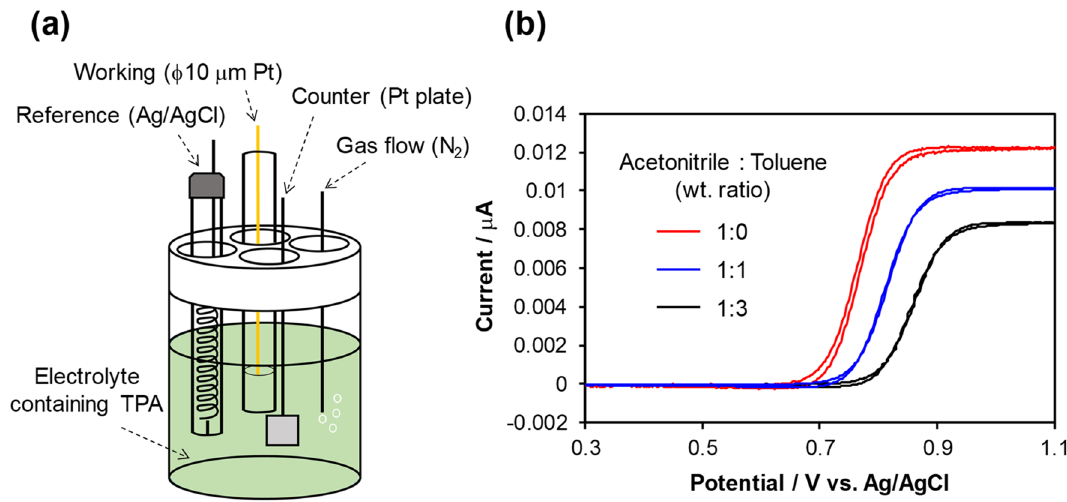
Figure 4. ( a ) Schematic diagram of the electrochemical cell used in this study. ( b ) Cyclic voltammograms of TPA at various acetonitrile:toluene weight ratios in the electrolyte at a supporting-electrolyte concentration of 50 mmol dm −3